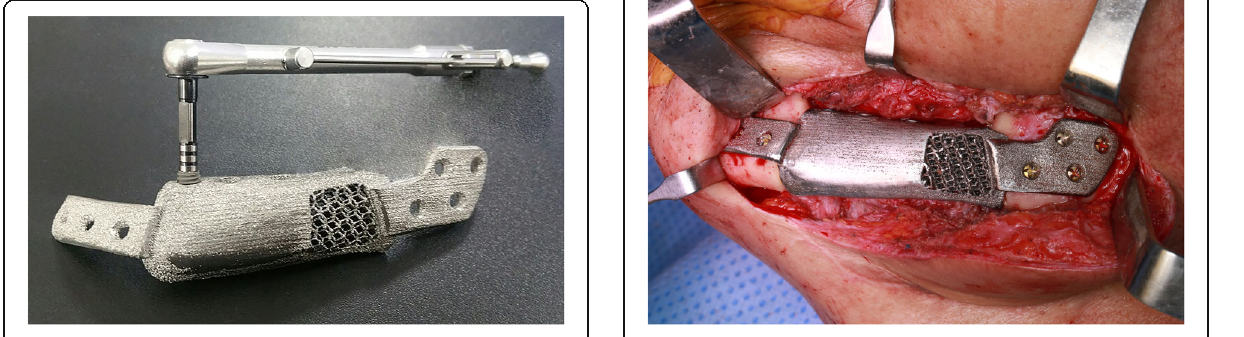
Fig. 3 Dental implant fixtures were installed in the titanium mandibular implant